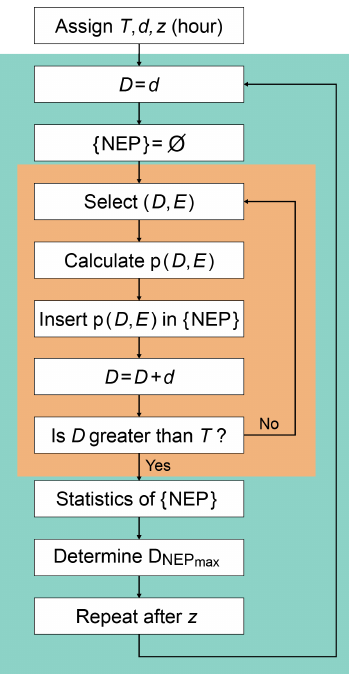
Figure 8. Logical scheme for the E-NEP algorithm. D is rainfall duration in hours. E is cumulated rainfall in milimetres. T is maxi- mum length of the considered rainfall period in hours. d is the time step used to increment the duration of the rainfall period, up to T in hours. z is the time interval before the next set of ( D,E) pairs is computed, in hours. { NEP } is the set of non-exceedance probability (NEP) values obtained for each ( D,E) pair adopting the method proposed by Brunetti et al. (2010) and Peruccacci et al. (2012). Statistics of { NEP } are 10th, 25th, 50th, 75th and 90th percentiles. and NEP max is the maximum value of NEP. D NEPmax , event rain- fall duration corresponding to NEP max . External (blue) loop is run every z hours or fraction of hour. Internal (orange) loop runs from d to T , in d time steps. In Figs. 9, 10 z and d were set to 1h and T to 96h. See text for